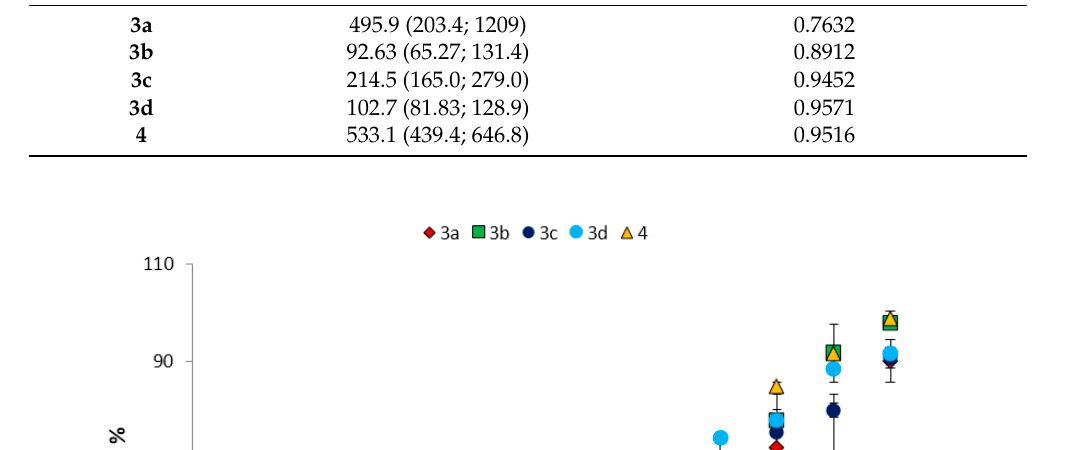
Table 1. Microtox ® EC 50 values (mg/kg of soil dry weight) of exposure of the luminescent marine bacteria Vibrio fischeri to tested aminophosphonates 3a – d and 4 , with respective 95% confidence limits (in brackets) obtained in the fit of the data.